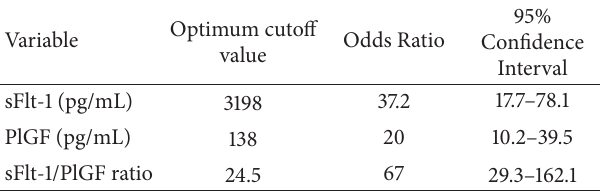
Table 5: Optimum cutoff values and odds ratio for preeclampsia according to cutoff